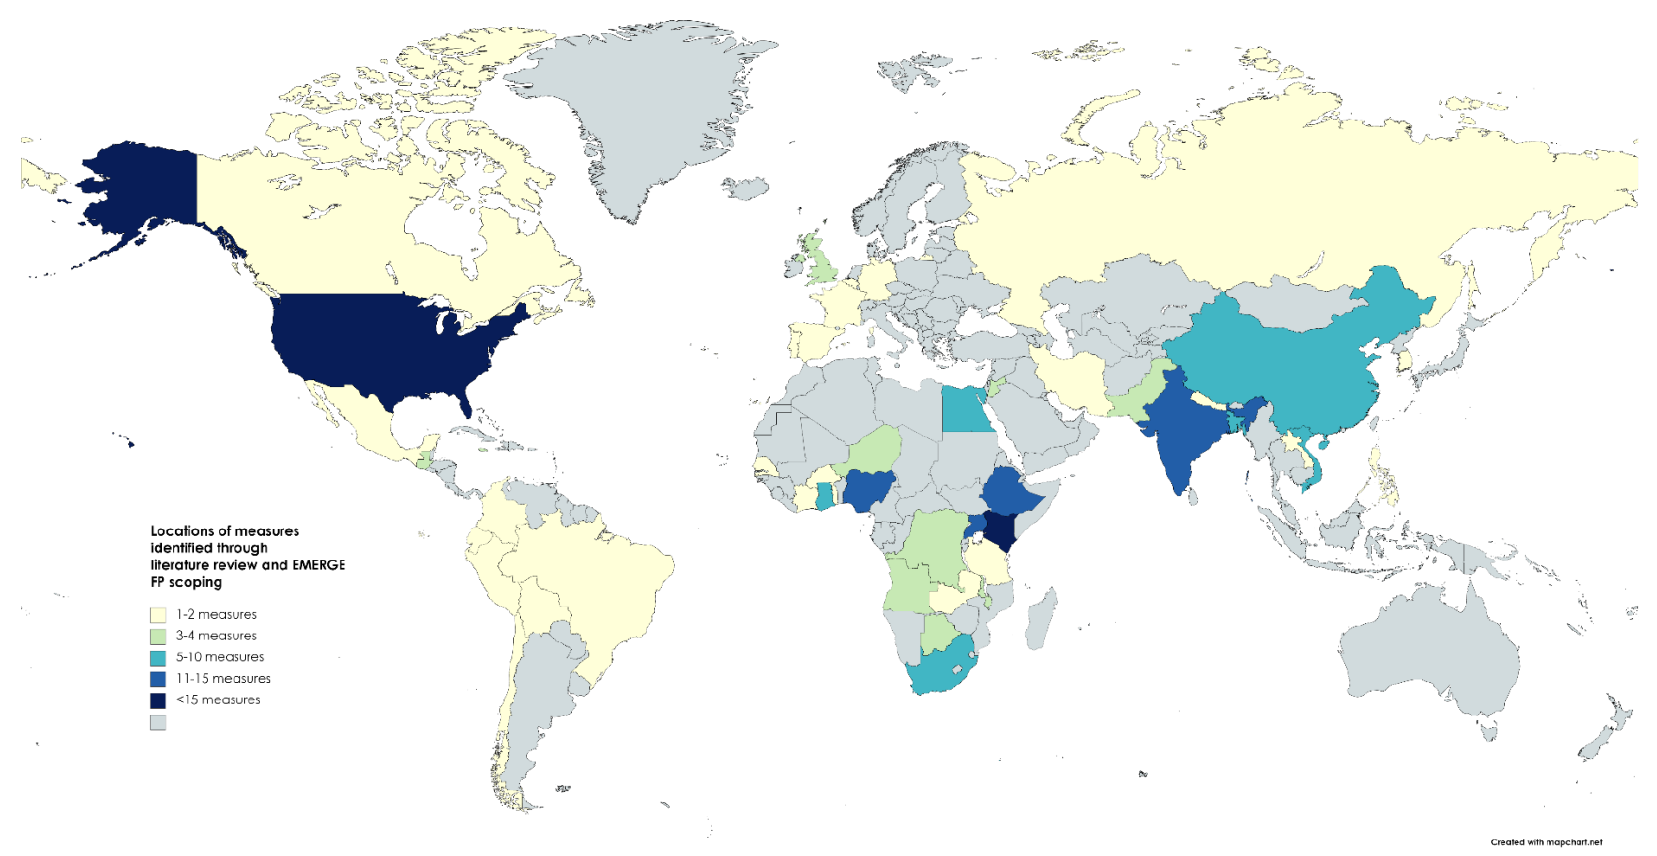
Figure 1: Geographical distribution of measures of gender equity in family planning